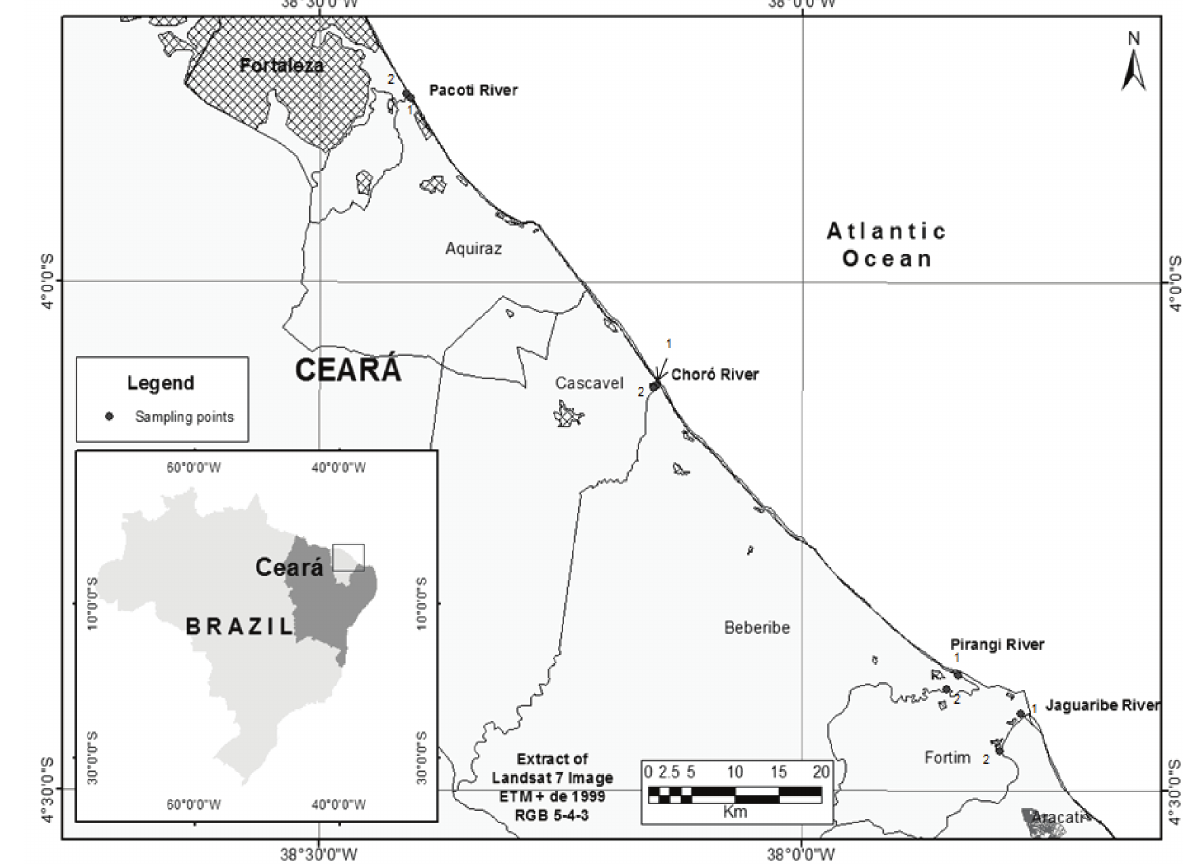
Figure 1 - Map of estuarine collection sites (Pacoti, Choró, Pirangi and Jaguaribe), Ceará,